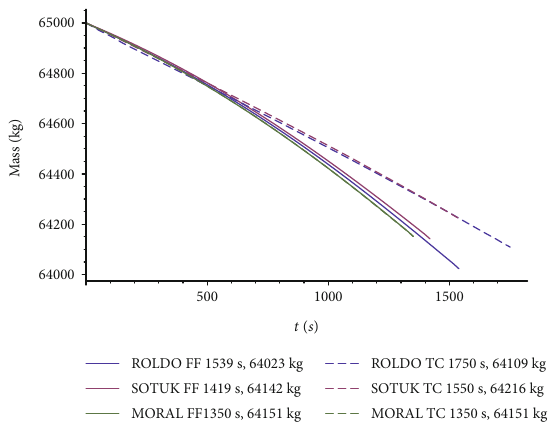
Figure 7: Experiment 1. Mass consumption with (TC, dashed lines) and without (FF, solid lines) time-based separation constraints. Table 3: Boundary conditions for Experiment 2. Symbol